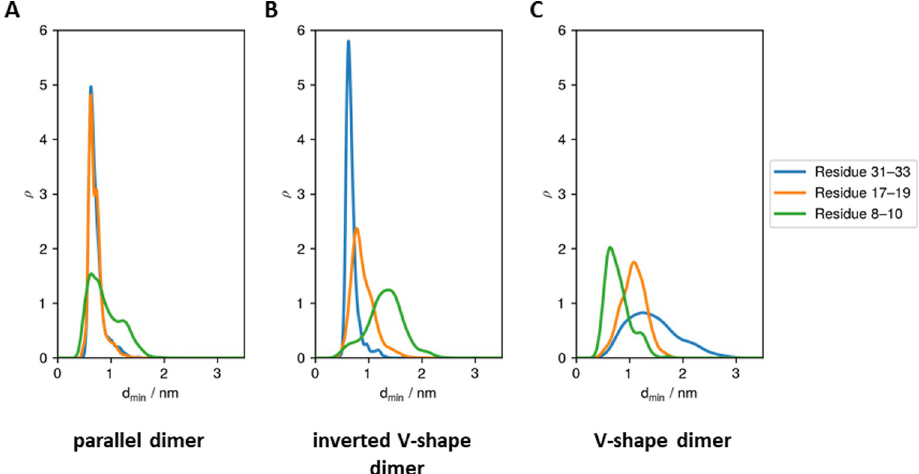
Fig 5. The distributions of the minimum distances between N-termini (green line), middles of helices (orange line), and C-termini (blue line) of SP-C monomers in each dimer topology: A) parallel dimer, B) inverted V-shape dimer, and C) V-shape